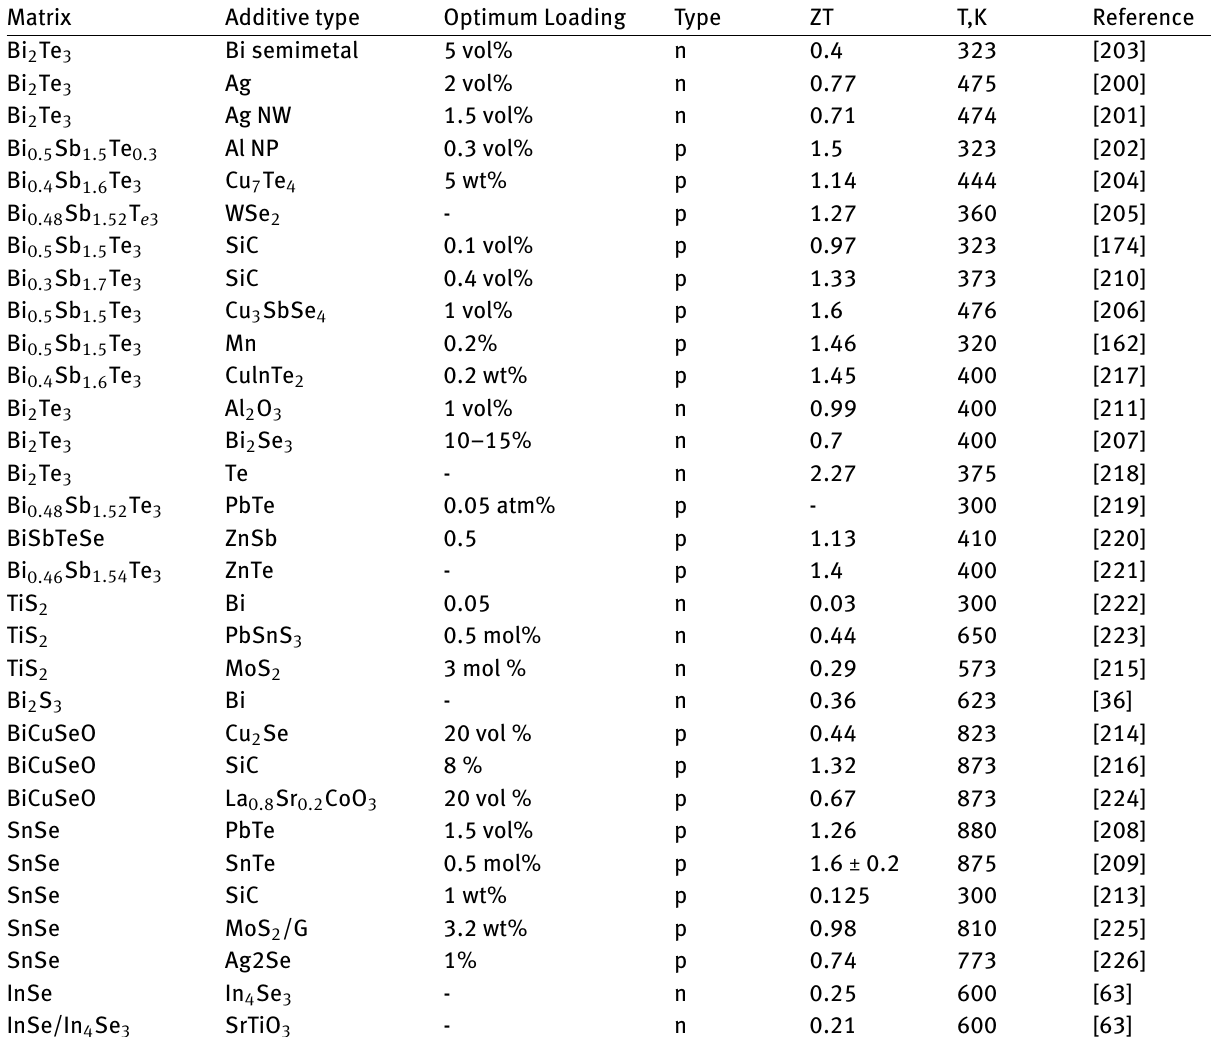
Table 6: ZT of some layered chalcogenides non carbon-based composites.